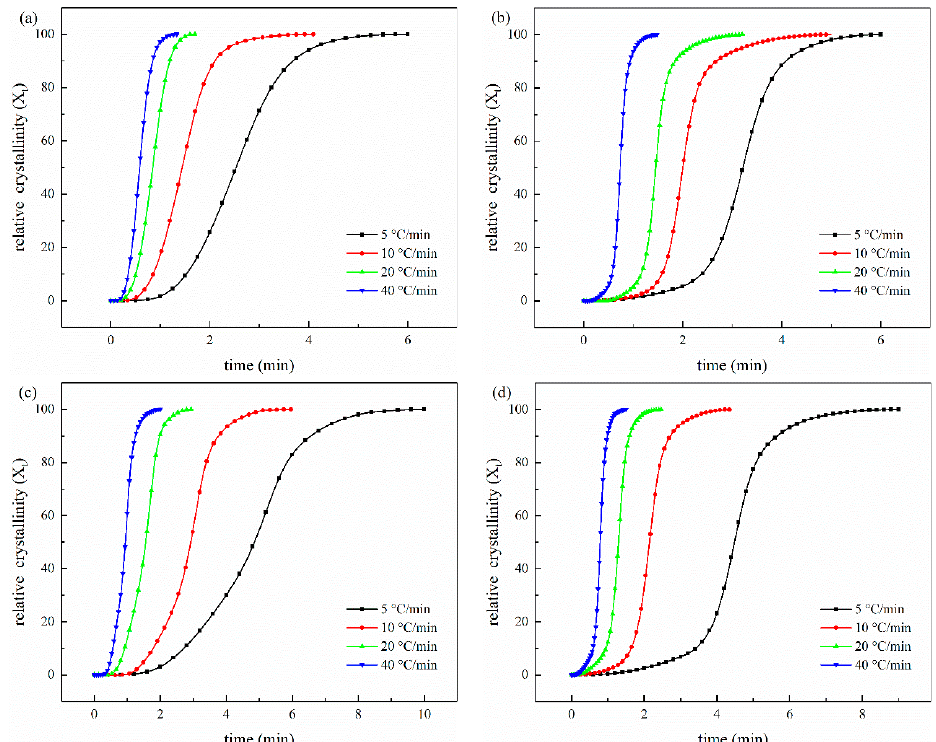
Figure 10. Relative crystallinity ( X t ) versus crystallization time (t/min) of non-isothermal melting crystallization of samples at different cooling rates: ( a ) (56 wt%) CCF/PET, ( b ) (0.1 wt%) CNT/CCF/PET, ( c ) (1.0 wt%) CNT/CCF/PET, ( d ) (2.0 wt%) CNT/CCF/PET.